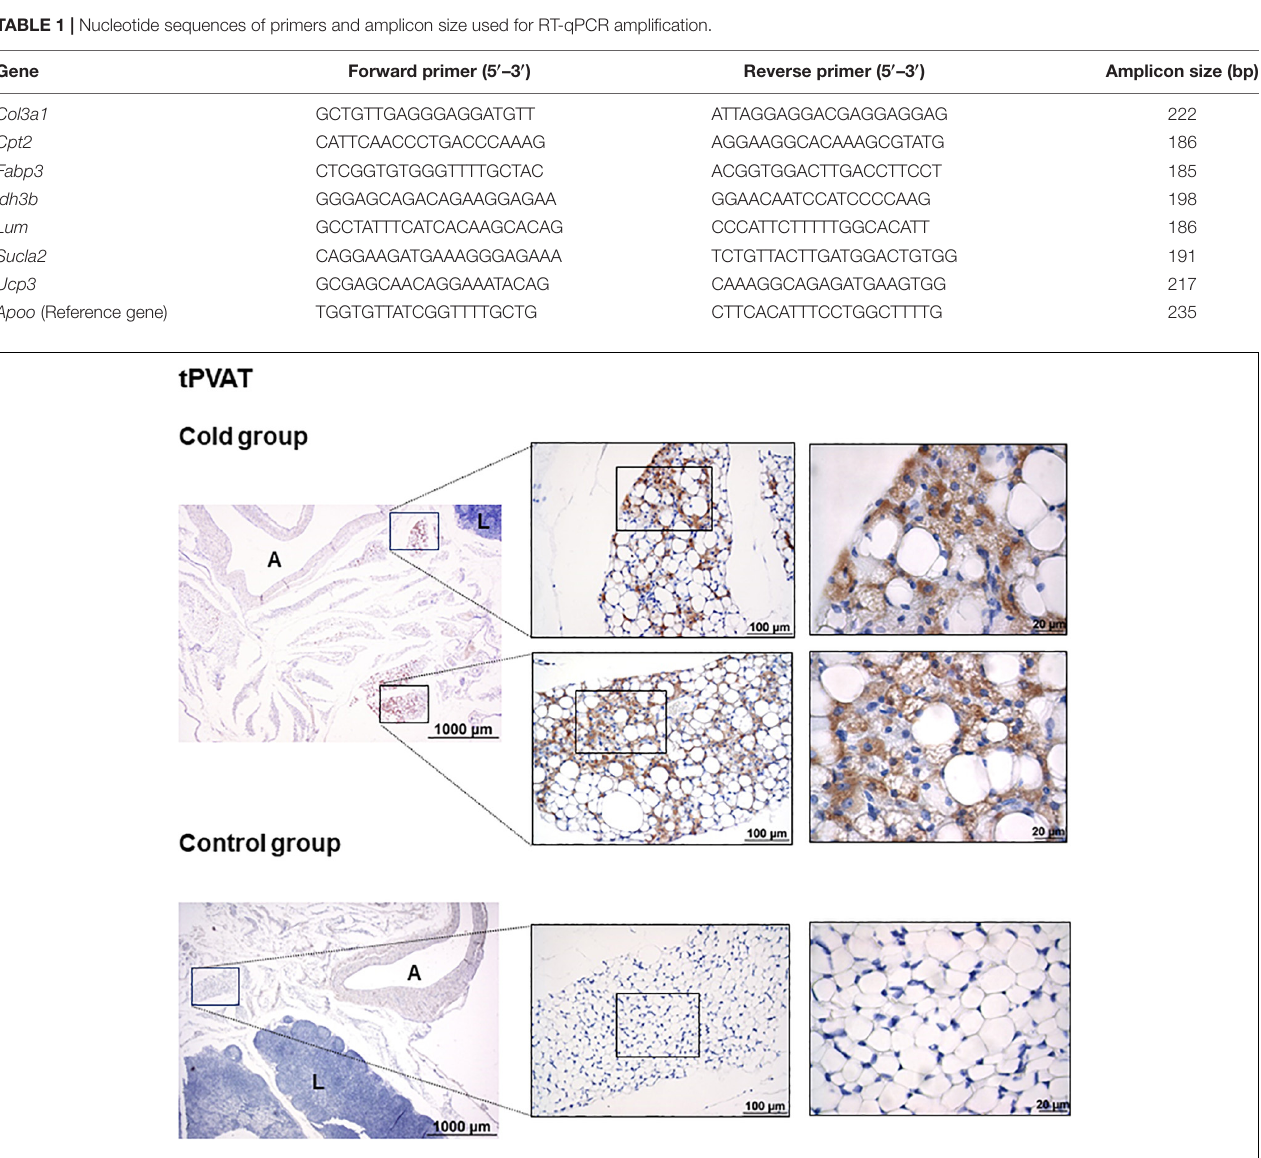
FIGURE 1 | Uncoupling protein 1 immunostaining in tPVAT of ferrets acclimatized to different room temperatures: 22 ◦ C (control group) or 4 ◦ C (cold group) for 1 week. A strong browning induction in cold-exposed ferrets is observed, characterized by increased appearance of adipocytes positive for UCP1 protein. A representative image of an animal of each group is represented. For each image, magnifications of 25 × , 200 × , and 630 × are shown. A, aorta; L, lymph